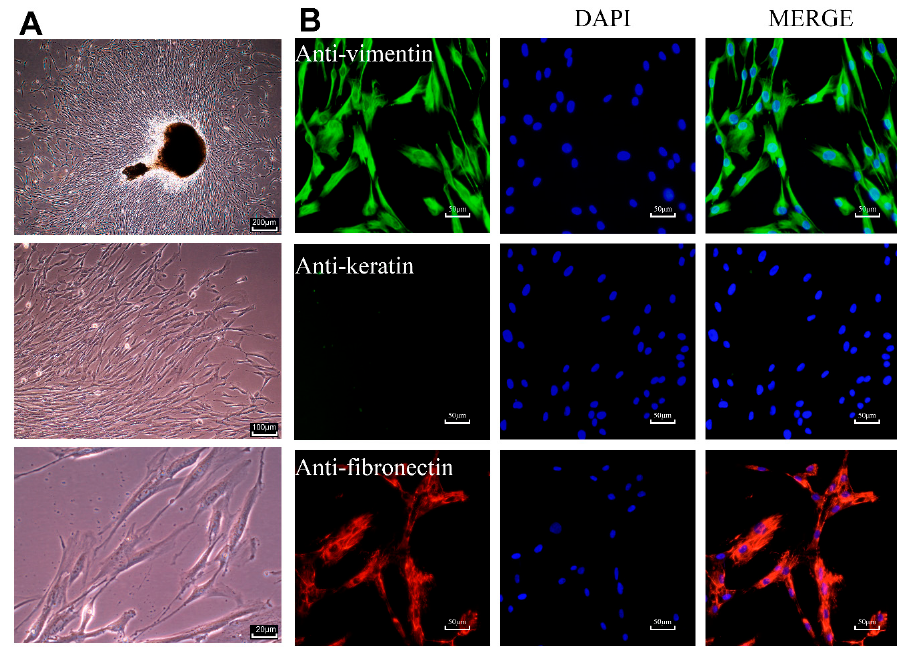
Figure 1. Cultivation and characterization of primary human periodontal ligament cells (HPLCs). ( A ) Cultured primary HPLCs observed under optical microscope. ( B ) HPLCs were characterized by anti-vimentin, anti-fibronectin and anti-keratin antibodies. The tested cells were positive for vimentin (green fluorescent) and fibronectin (red fluorescent) and negative for keratin (green fluorescent which was